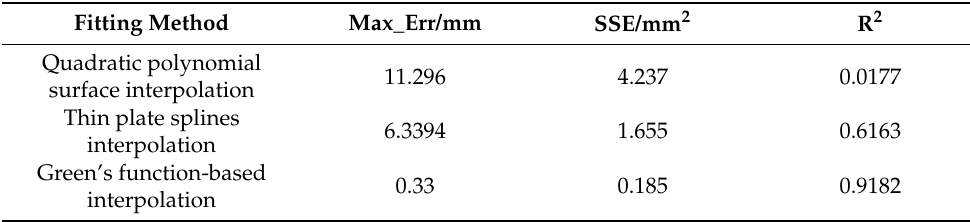
Figure 9. Residual error diagram generated from Green’s function-based interpolation method. Table 3. Residual error statistics of the three interpolation methods.